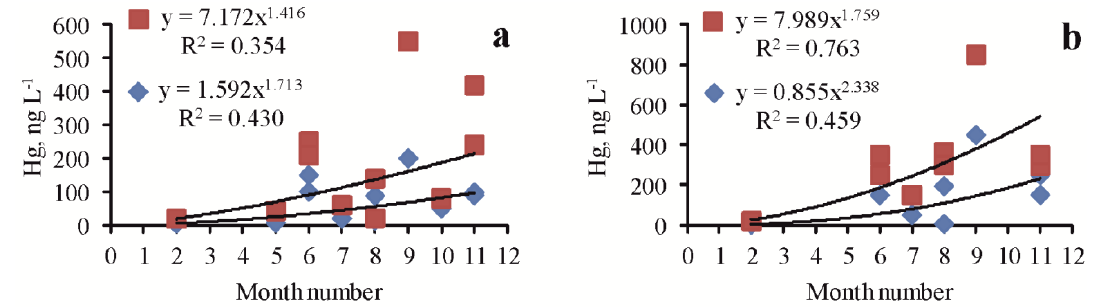
Figure 3. Seasonal changes in the concentration of the Hg dissolved forms of mercury in the lakes Kiyatskoe ( a ) and Bakalskoe ( b ).